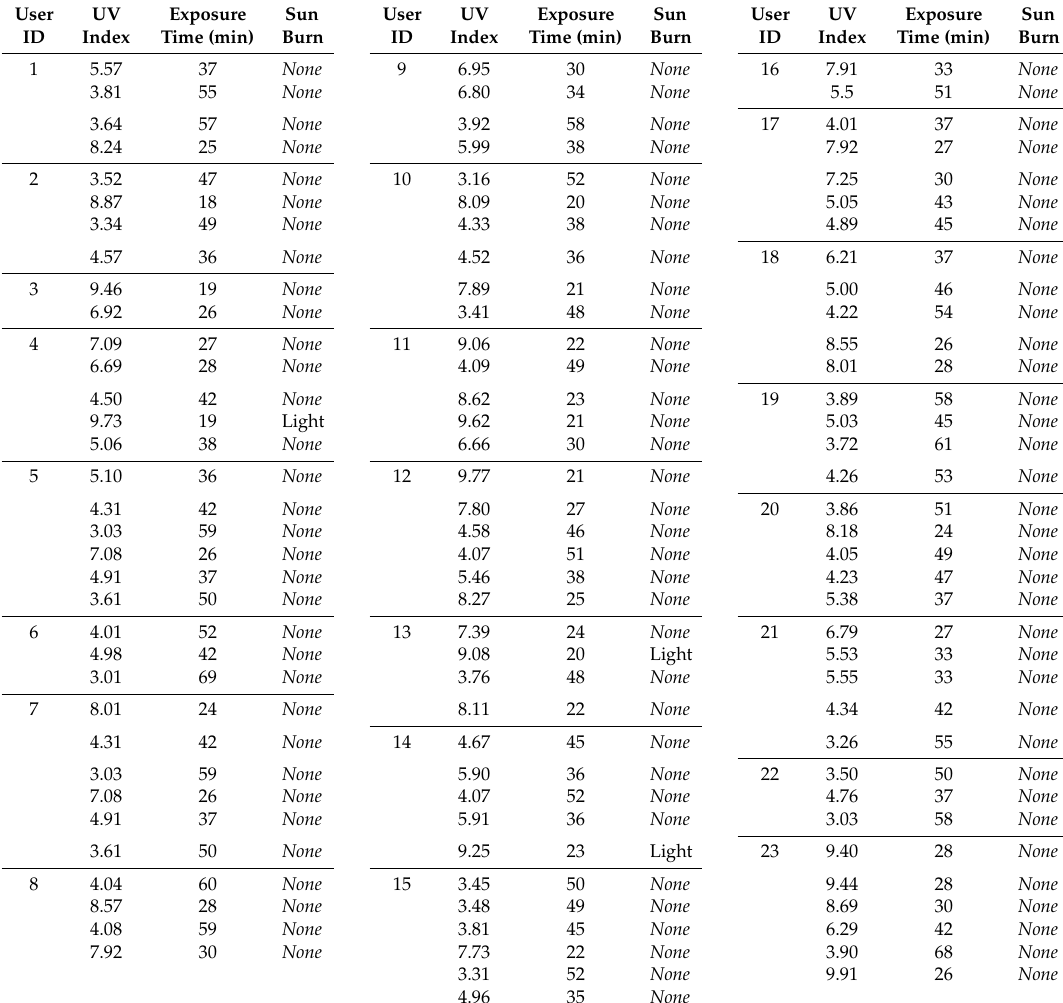
Table 5. The results from the sessions in real